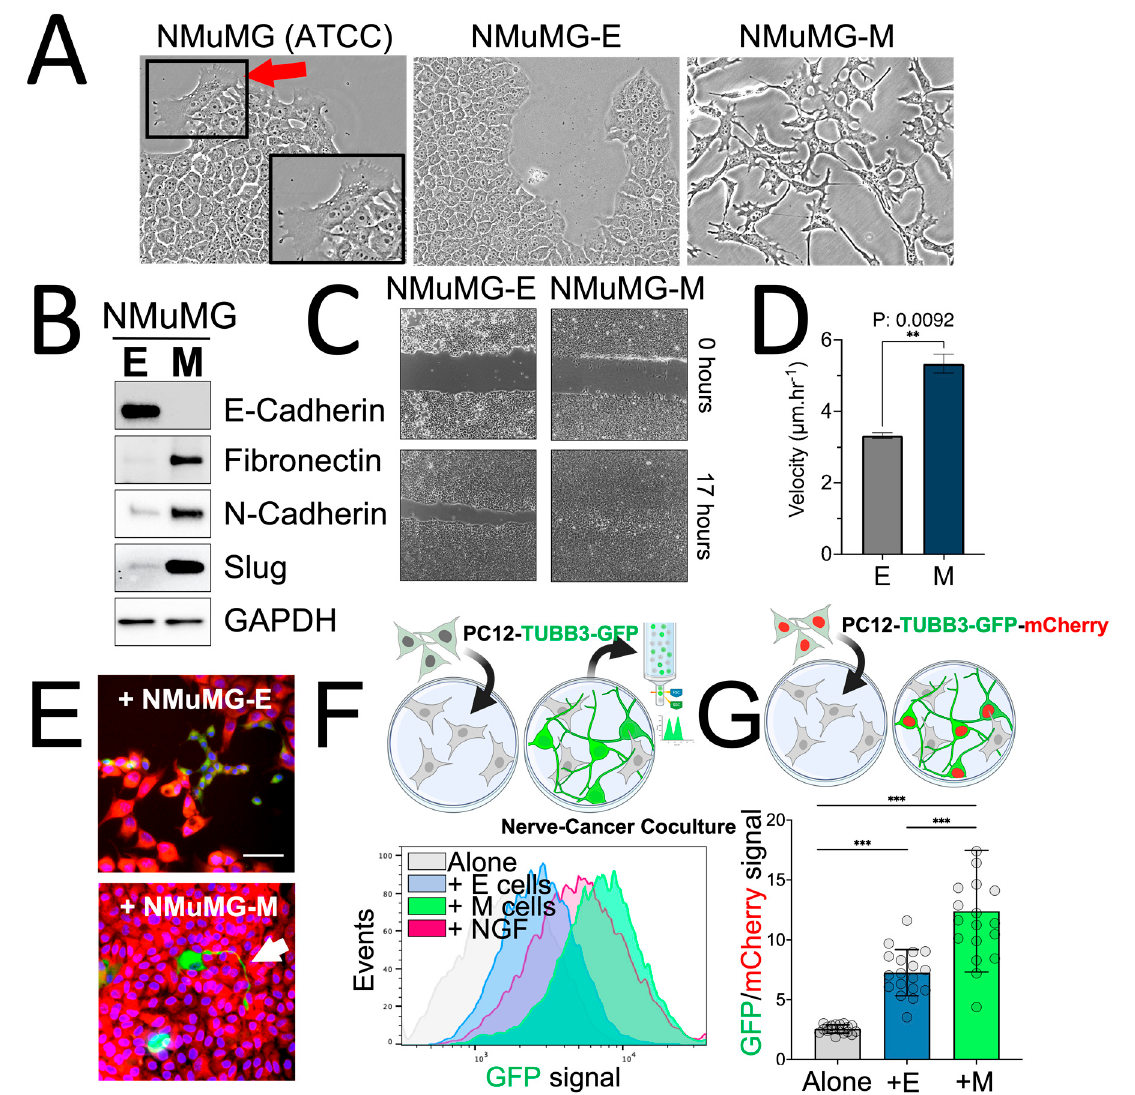
Figure 5. Breast cancer plasticity promotes neuron precursor axonogenesis. ( A ) To test the model developed for studying cancer-induced neuronal differentiation, we developed a model of breast cancer plasticity and epithelial-mesenchymal transition (EMT). The NMuMG cell cultures from ATCC are mostly epithelial cells but are heterogenous cultures having mixed phenotypes, with a few cells exhibiting mesenchymal morphologies (red arrows). NMuMG clones with epithelial (NMuMG-E) and mesenchymal (NMuMG-M) morphologies were isolated by single-cell seeding and regrowing of isogenic culture having epithelial or mesenchymal characteristics. ( B ) Western blot analysis of the regenerated culture confirms the occurrence of an EMT, consisting of the expression of the epithelial marker E-cadherin in NMuMG-E cells that disappears in NMuMG-M cells and the acquisition of the expression of mesenchymal markers fibronectin, N-cadherin, and Slug in NMuMG-M cells (Original Western blot, see Supplementary File S1). GAPDH serves as a loading control. ( C ) Wound healing assay shows a greater velocity of migration in NMuMG-M cells com- pared to NMuMG-E cells, con fi rming the biological impact of the EMT on the cells’ aggressive be- haviors. ( D ) To verify the relevance of NMuMG E/M to re fl ect the cell EMT-related plasticity func- tionally, we performed wound healing assays and quanti fi ed them by live-cell microscopy with the work fl ow published by Jonkman and colleagues [48]. ( E ) Fluorescence microscopy imaging of PC12-TUBB3-GFP cells in coculture with NMuMG-E or NMuMG-M constitutively expressing the mCherry fl uorophore (red Channel), show increased GFP signal with the NMuMG-M cells, con- sistent with the development of extended neurites (White arrow). ( F ) PC12-TUBB-GFP cells were